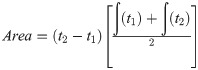
Efficacy of MMP9-targeting antibody in mouse DSS model of colitis.Treatment was initiated after establishment of colitis (Day 6): Vehicle control, IgG control (30 mg/kg), and AB0046 (30 mg/kg) were dosed every three days, and entanercept (10 mg/kg) was dosed every two days (A) The area under the curve (AUC) was calculated for daily body weight changes in each animal by the trapezoidal rule method;Area=(t2−t1)[∫(t1)+∫(t2)2]. (B) The incidence of diarrhea was recorded daily and the AUC calculation was performed as above. (C) Endoscopic evaluation was performed on all groups at study termination. Scoring was based on the single most severe lesion observed in the distal 5 cm of colon. (D) Blinded histopathological analysis was performed on colons excised at study termination. The degree of inflammation (primarily macrophages and neutrophils), edema, and necrosis was scored. (E) Images representative of study groups (40X magnification) were taken by a pathologist and highlight areas of inflammation/mucosal necrosis (black arrows) and edema (blue arrows), which are reduced in AB0046 and etanercept-treated animals. Statistical significance was assessed by one-way ANOVA with Dunnett’s Multiple Comparison post-test. P value designations are as follows: * < 0.05, ** < 0.01, *** <0.001, **** < 0.0001.